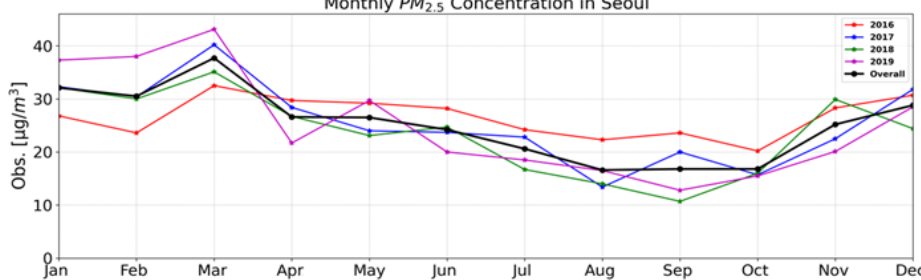
Figure 5. Time series of the monthly average PM 2 . 5 concentrations from 2016 to